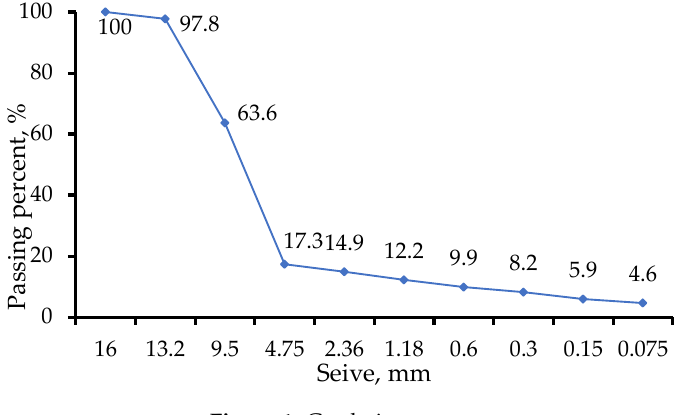
Figure 1. Gradation curve.